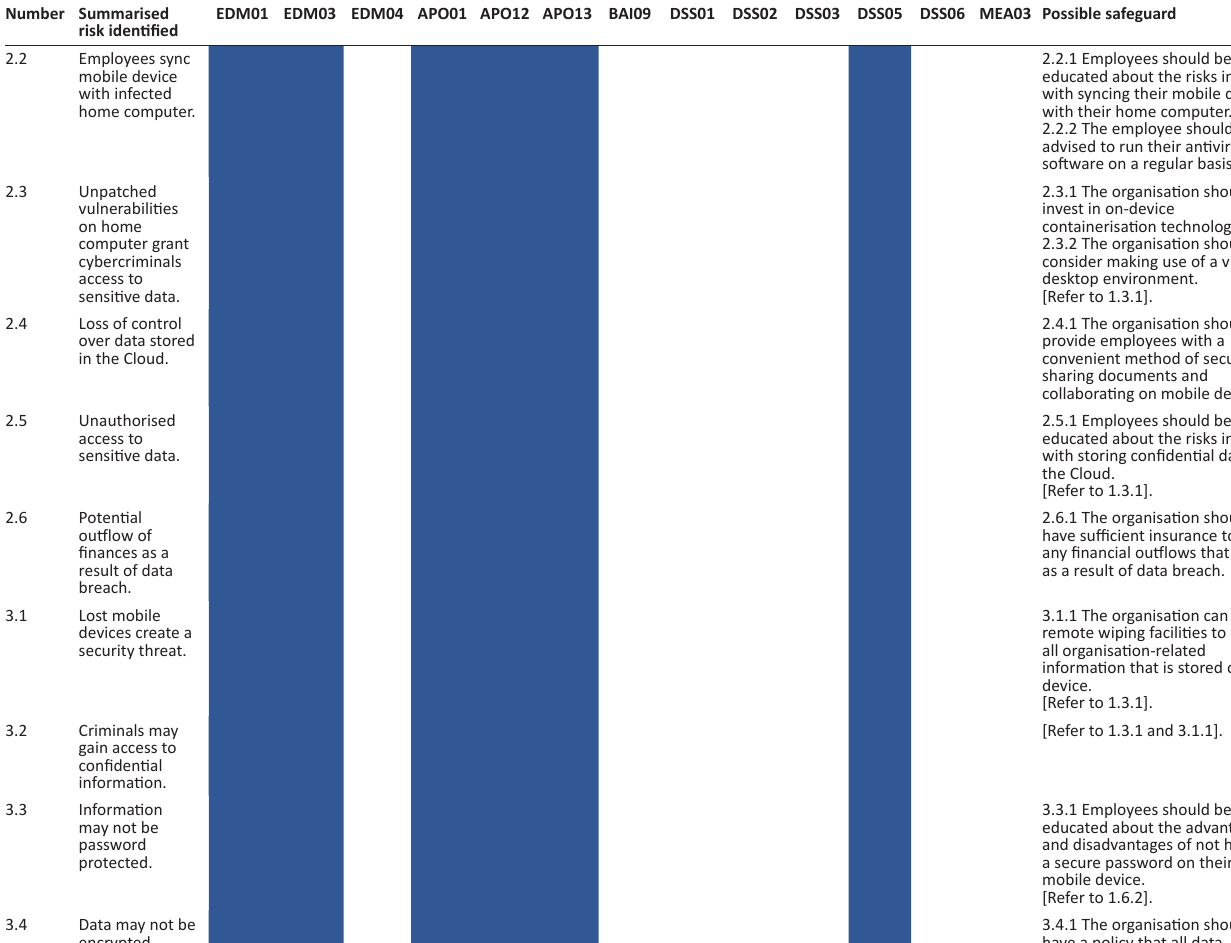
FIGURE 1 (Continues...): Mapping risks to possible